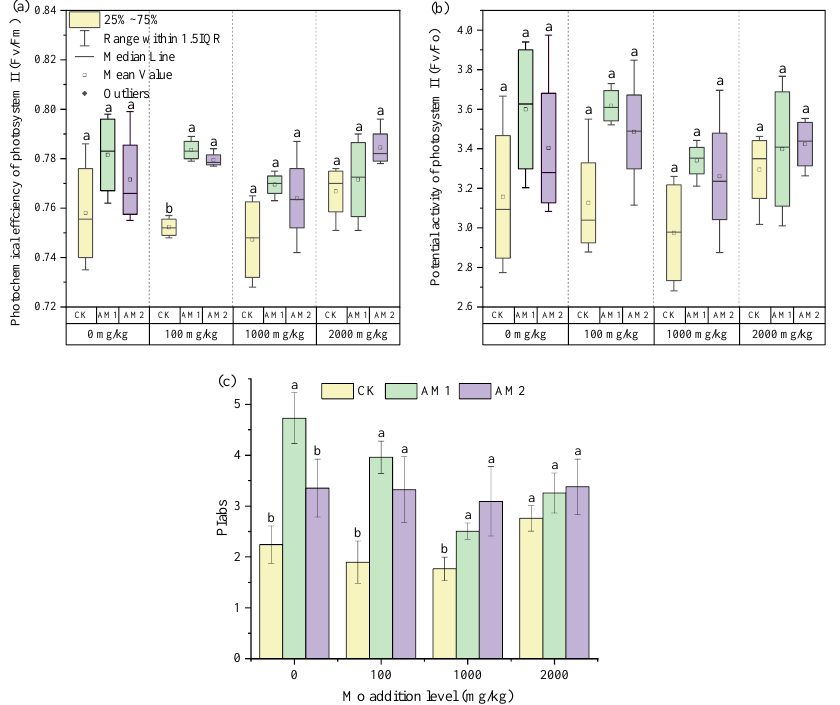
Figure 5. The specific activity parameter of photosystem II. photochemical efficiency ( a ), potential activity ( b ), and photosynthetic performance index ( c ). Different lowercase letters indicate significant differences under the different inoculation conditions at the same level of Mo addition, determined using a one-way ANOVA followed by Duncan’s multiple range test ( p < 0.05).